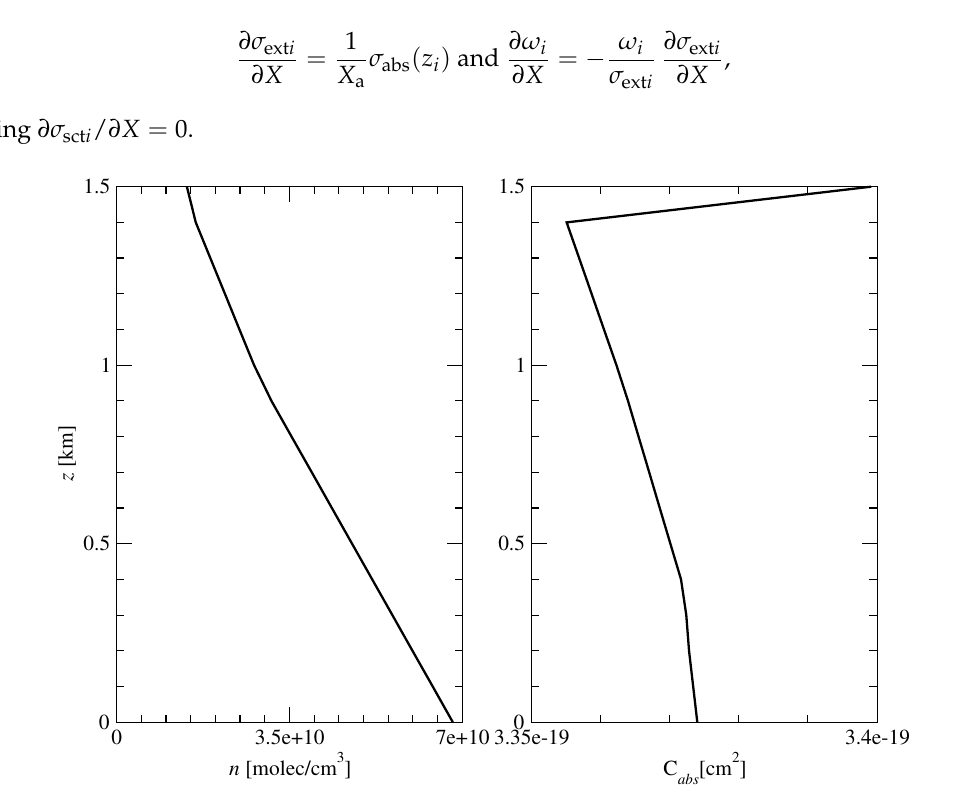
Figure 8. Number density ( left ) and absorption cross section ( right ) profiles for NO 2